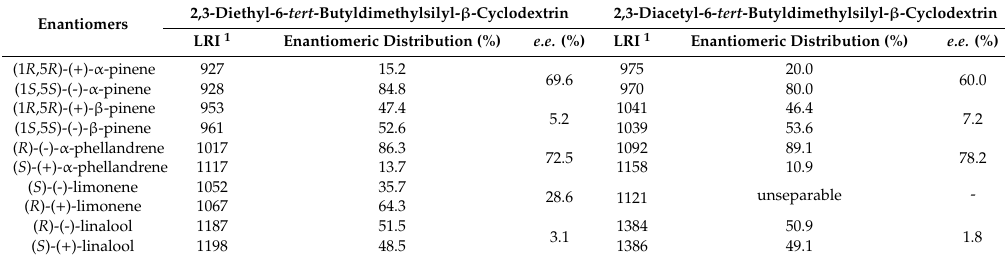
Table 2. Enantioselective analysis of some chiral constituents of P. coruscans EO on 2,3-diethyl-6- tert -butyldimethylsilyl- β -cyclodextrin and 2,3-diacetyl-6- tert -butyldimethylsilyl- β -cyclodextrin.